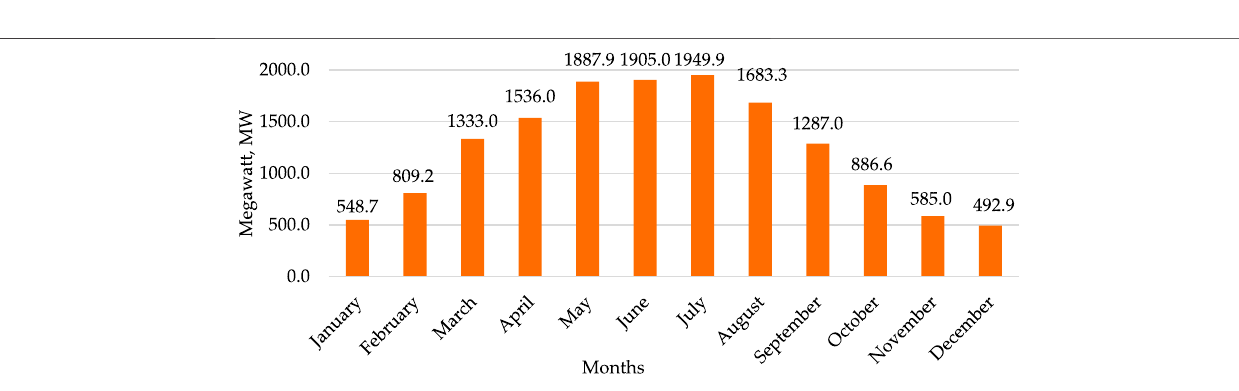
FIGURE 3 | Annual irregularity of electricity generation at a 10 MW solar power plant in the Orenburg region (2019).